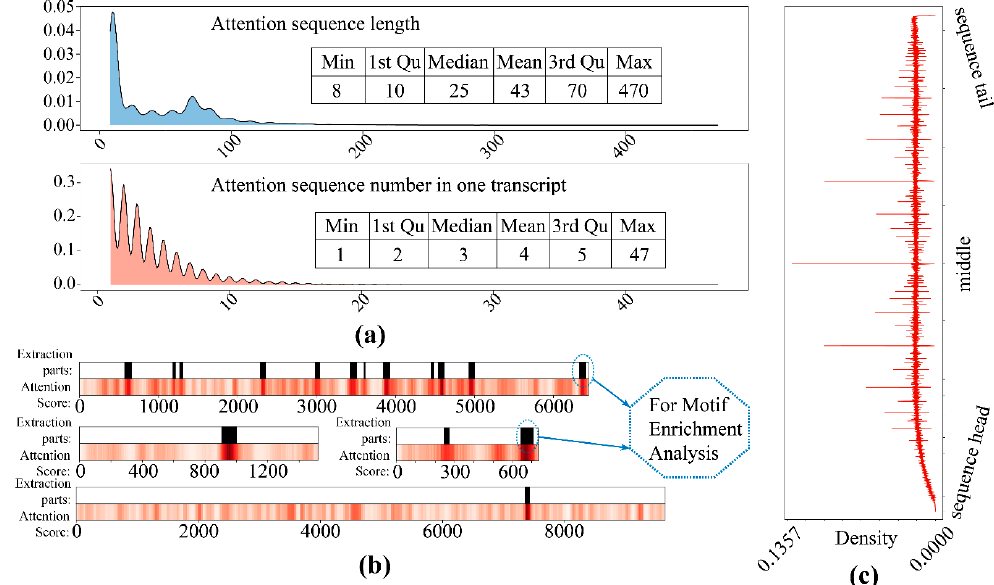
Figure 8. The high attention sequence distribution. ( a ) The length distribution (upper) and the attention sequence number for each transcript distribution (lower); ( b ) the extraction of attention sequence for motif enrichment; ( c ) density distribution of attention loci on all